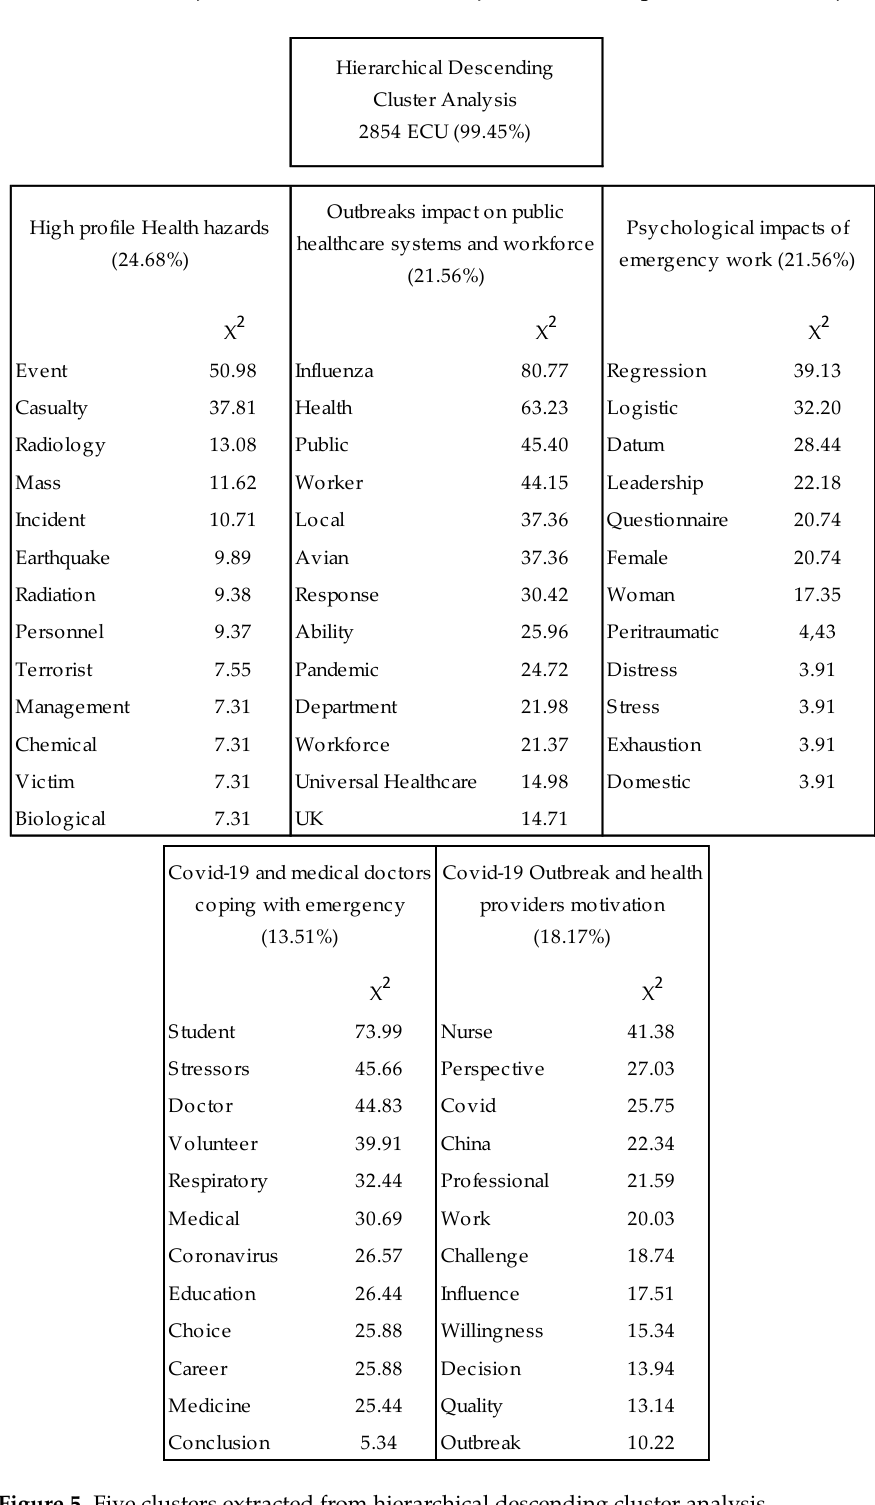
Figure 5. Five clusters extracted from hierarchical descending cluster analysis.